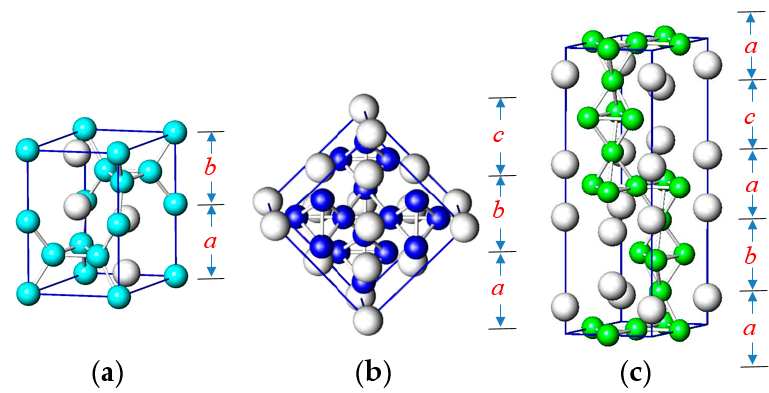
Figure 1. Schematic of ( a ) C14 (hexagonal), ( b ) C15 (cubic), ( c ) and C36 (rhombohedral) crystal structures [28].